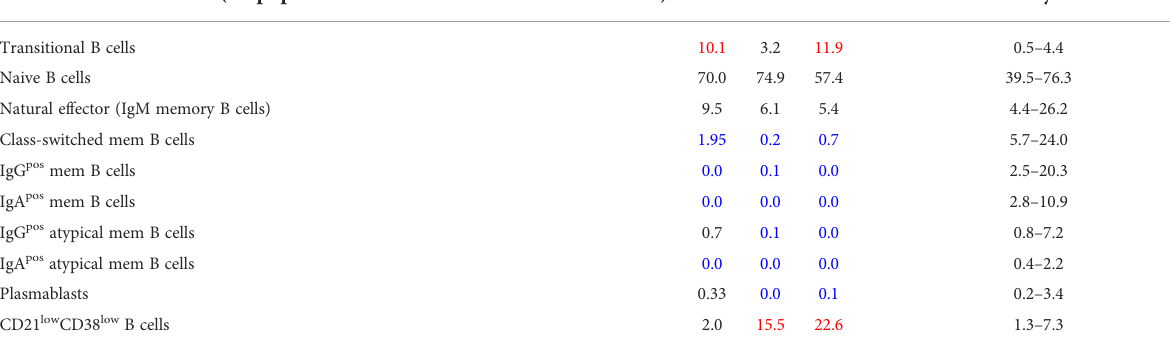
TABLE 1 Frequencies of B-cell subsets in blood. B-cell subsets in blood (all populations calculated as % of total B cells) Transitional B